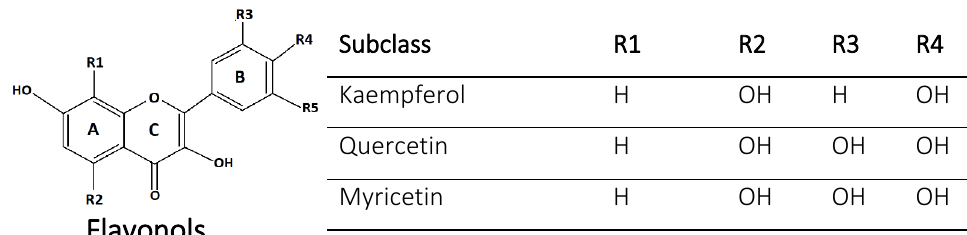
Figure 2. Flavonols: chemical structures, types and substitution positions in the basic skeleton.